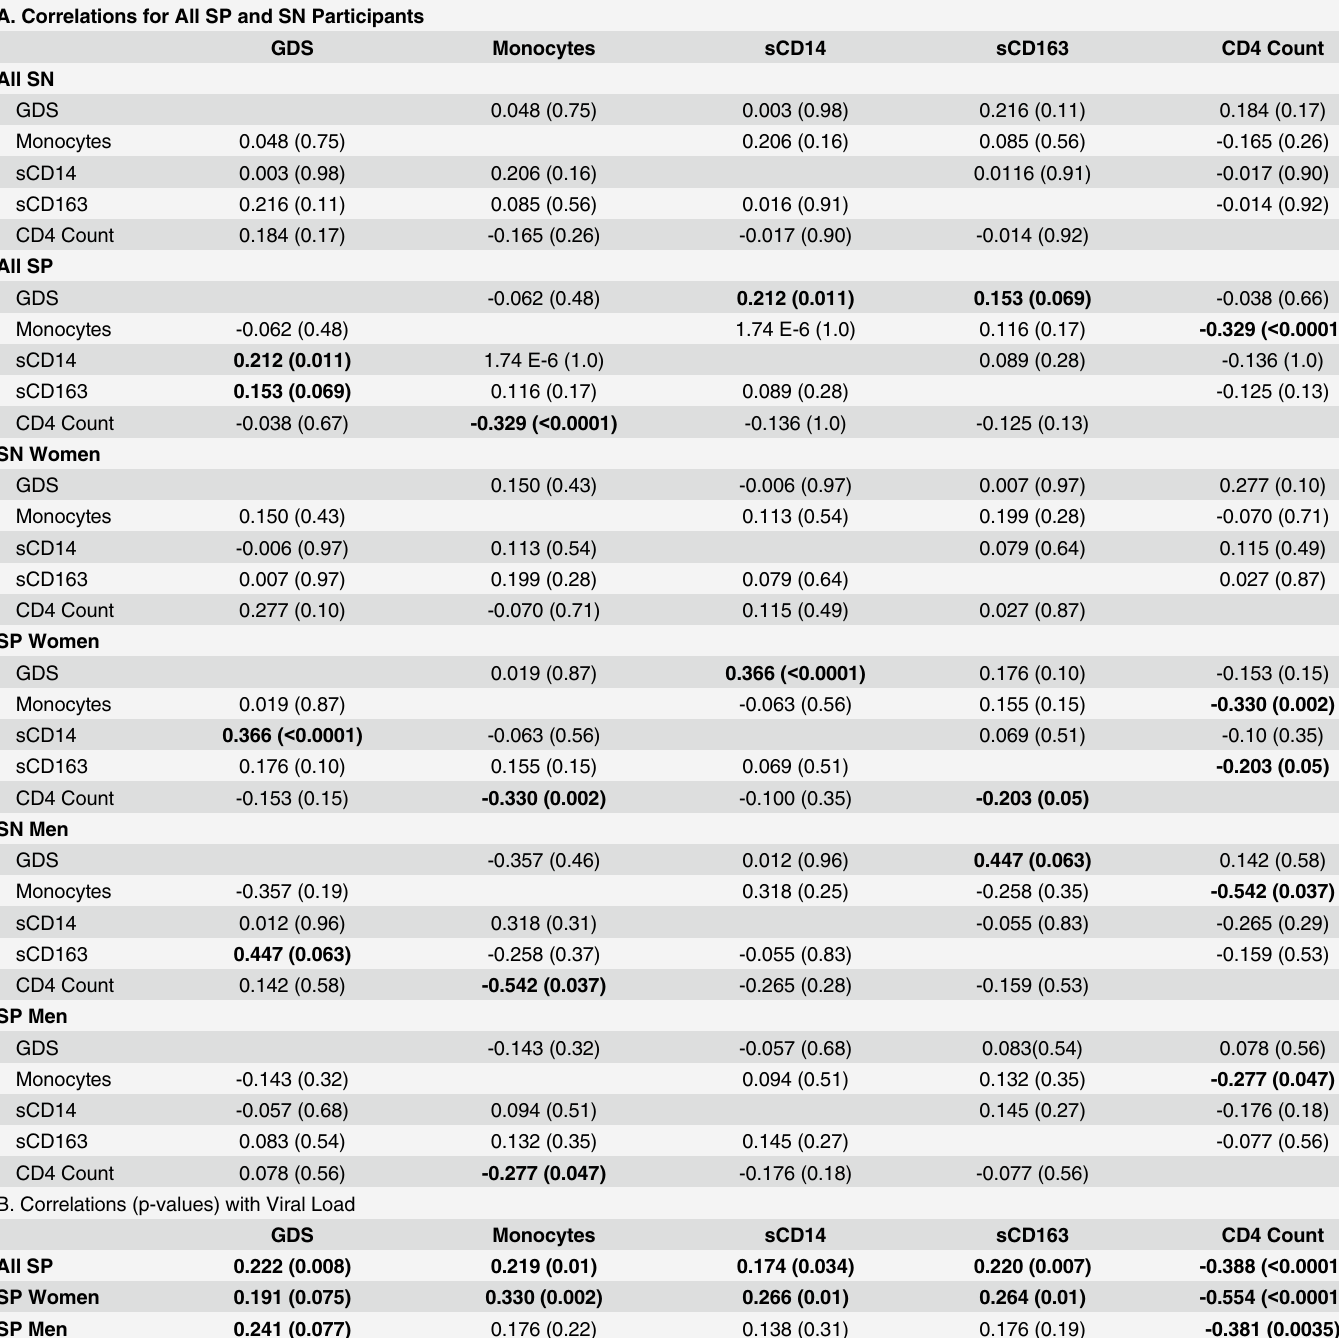
Table 6. Correlations (p-values) between Clinical Laboratory Parameters of HIV Infection and Measures of Monocyte Activation by Subject HIV Serostatus and Gender. A. Correlations for All SP and SN